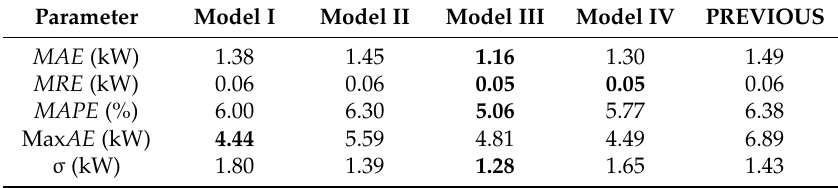
Table 16. Results obtained by MOGA and PREVIOUS models over Test E, for a PH of 1 h.